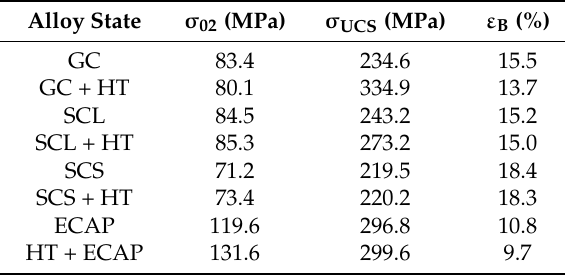
(SCS) decreased the tensile yield stress (see Table 3). Corresponding values obtained in compression are slightly higher (see Table 4). True stress–strain curves obtained in tension and compression are introduced in Figure 8 for SCS and SCS + HT alloys. Small serrations were observed on curves received in compression. These serrations are more pronounced in the alloy after heat